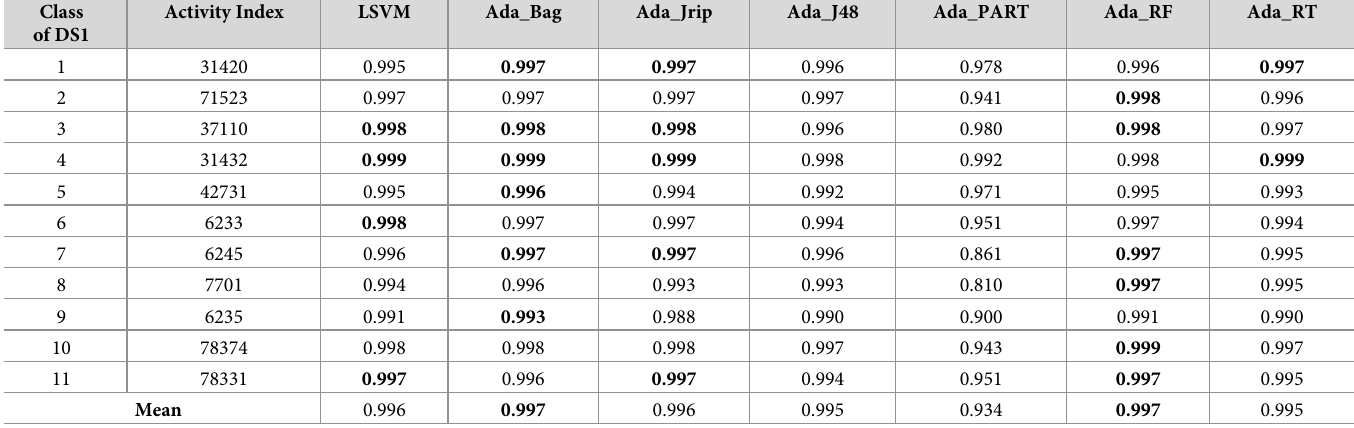
Table 7. Specificity measure for the prediction of new bioactive molecules with DS1 (normal